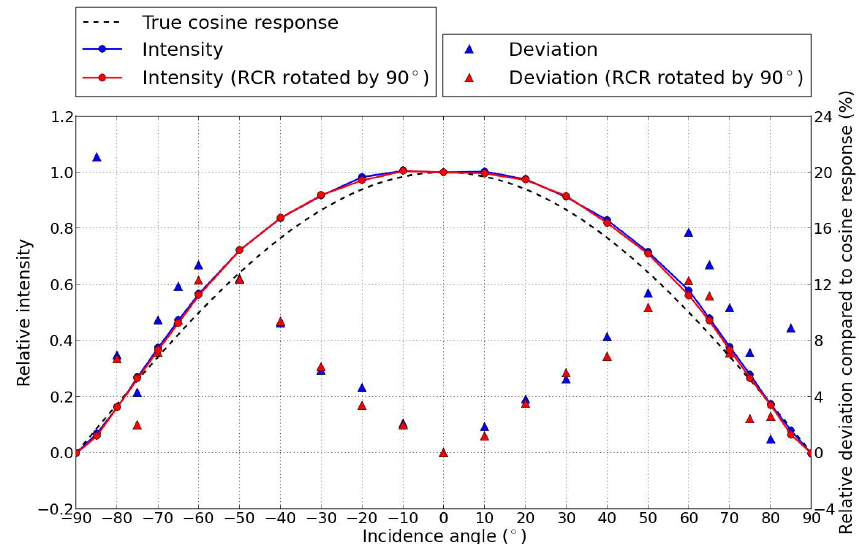
Fig. 3. Angular response of the RCR sensor at 500nm, for incidence angles ranging from − 90 ◦ to 90 ◦ . The true cosine response is represented by the dashed black line and the relative intensities normalized by I( 0 ◦ ) are represented by blue circles. Blue triangles represent absolute values of the deviation of the measured response from a true cosine response (see Eq. 2). The RCR response has also been measured after rotating the sensor along its axis by 90 ◦ (red circles and